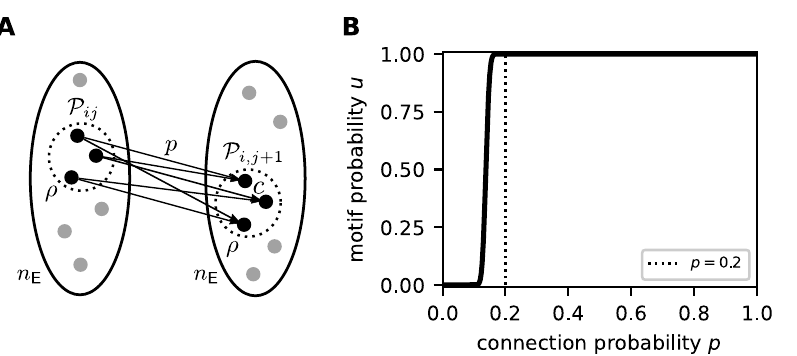
Fig 5. Existence of divergent-convergent connectivity motifs in a random network. A) Sketch of the divergent- convergent potential connectivity motif required for the formation of sequence specific subnetworks during learning. See main text for details. B) Dependence of the motif probability u on the connection probability p for n E = 150, c = 5, and ρ = 20 (see Table 2). The dotted vertical line marks the potential connection probability p = 0.2 used in this